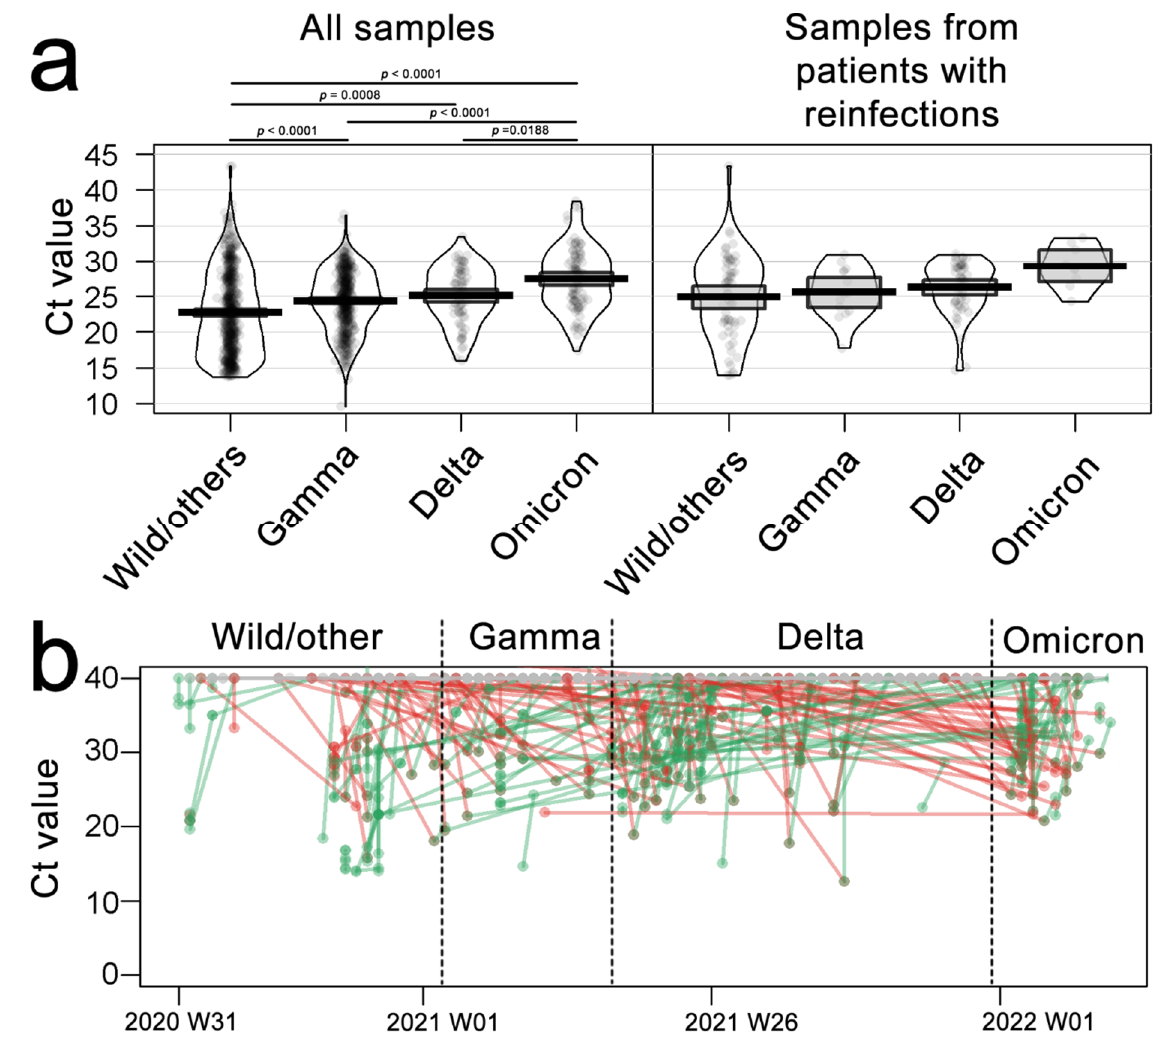
Figure 3. Cycle-threshold values for N gene target SARS-CoV 2 detection. ( a ) Ct values of diagnosis for each evaluated variant during the pandemic in all samples (left) or patients with multiple collections and reinfections. ( b ) Dots and lines plot represent Ct values for each patient tracked for multiple infections, gray lines represent negative results from the same patient, red lines represent Ct decrease (an increase in viral load), and green lines represent Ct increase (decrease in viral load). p -values derived from ANOVA, followed by Tukey’s test. Each dot represents a sample, the box represents the interquartile range, and the lines are the kernel-smoothed distribution.